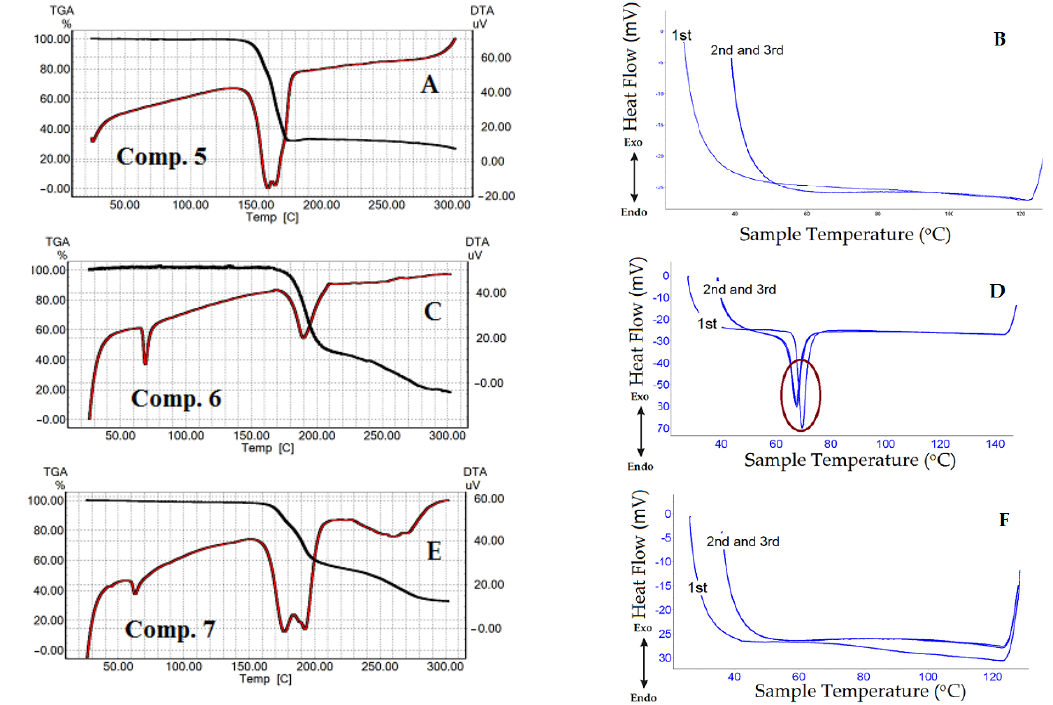
Figure 5. ( A , C , E ): TGA/DTA curves for comps. 5 – 7 . ( B , D , F ): DSC triple heating curves of comps. 5 – 7 in the temperature range before compound decomposition. Endothermic peaks that occurred after triple heating are marked by circles.